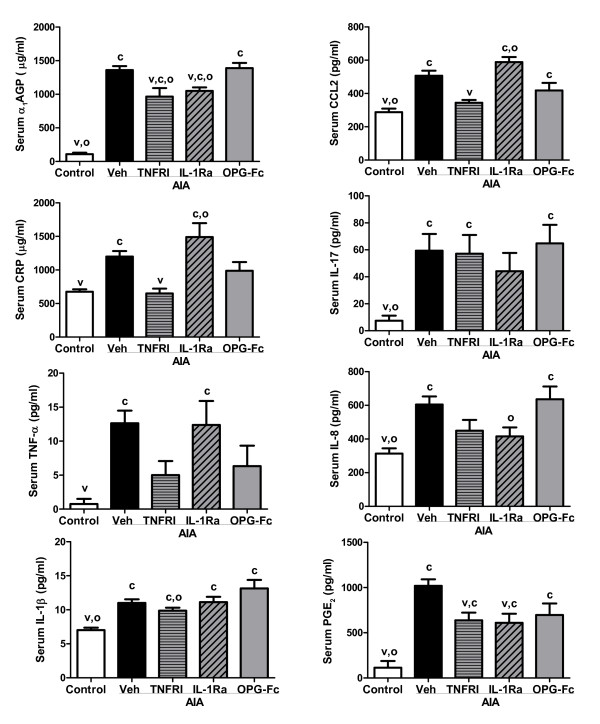
Serum markers and mediators of inflammation in adjuvant-induced arthritis (AIA) rats. Values were determined on day 14 post onset, 10 days after the initiation of treatment. Data represent means ± standard error of the means, n = 8/group. cSignificantly different from control (nonarthritic) rats, P < 0.05. vSignificantly different from vehicle (Veh)-treated arthritic rats, P < 0.05. oSignificantly different from osteoprotegerin (OPG)-treated arthritic rats, P < 0.05. α1AGP, acute-phase protein alpha-1-acid glycoprotein; AIA, adjuvant-induced arthritis; CCL2, chemokine (C-C motif) ligand 2; CRP, C-reactive protein; PGE2, prostaglandin E2.